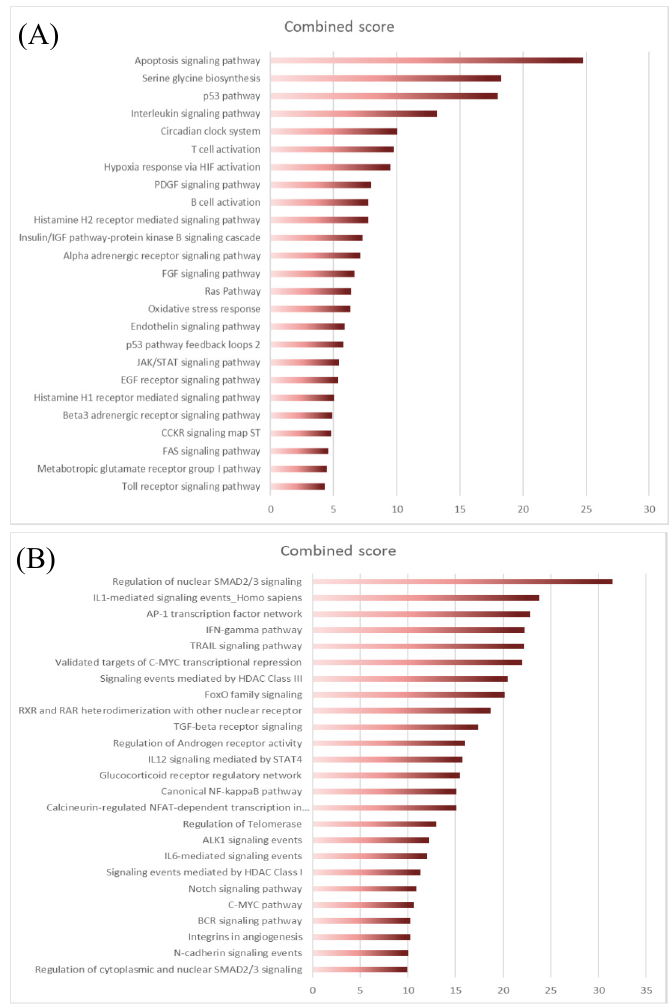
Figure 2. EnrichR analysis of differentially expressed transcriptome of FL niche players using NCI Nature library ( A ) or Panther library ( B ). The top 25 pathways were sorted according to the EnrichR combined scores.